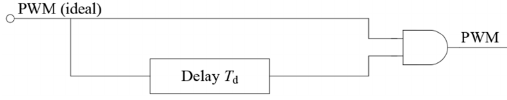
Figure 4. Dead time generation circuit.